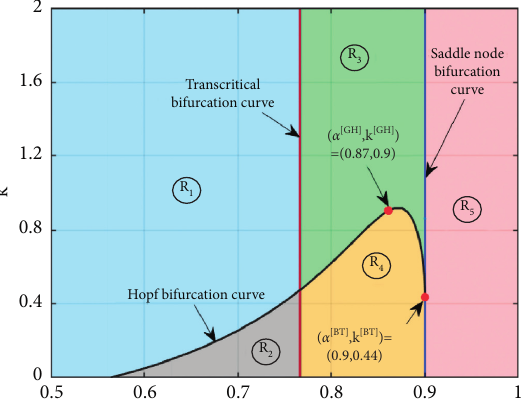
Figure 8: Stability region of different equilibrium points and two-parametric bifurcation diagram of the model system (39) in α − k parametric plane. One transcritical bifurcation curve (magenta-coloured line), one saddle-node bifurcation curve (blue-coloured line), and one Hopf bifurcation curve (black-coloured curve) split up the whole region into five small subregions ( R coexistence steady state ( E bifurcation. Multiple coexistence ( E stable and